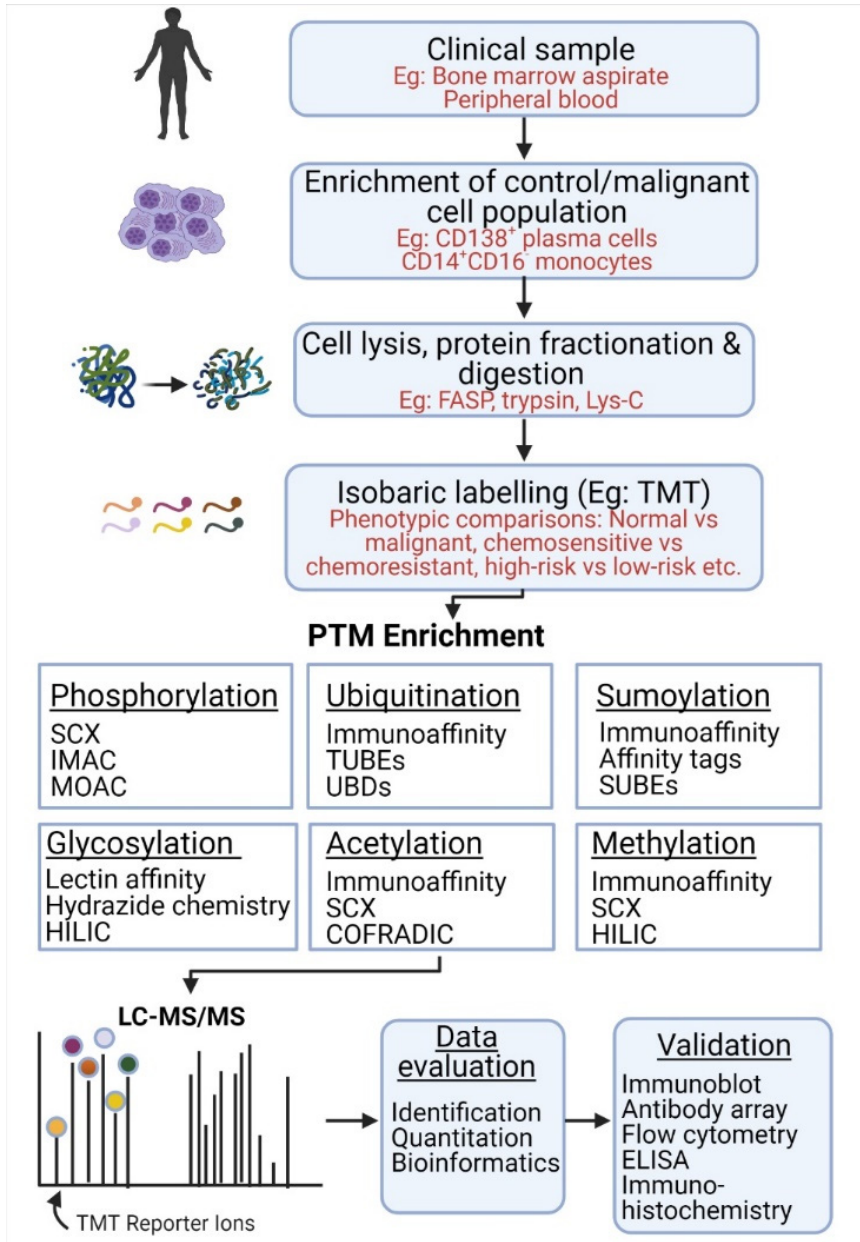
Figure 3. Bottom-up proteomics workflow for PTM analysis and subsequent validation.